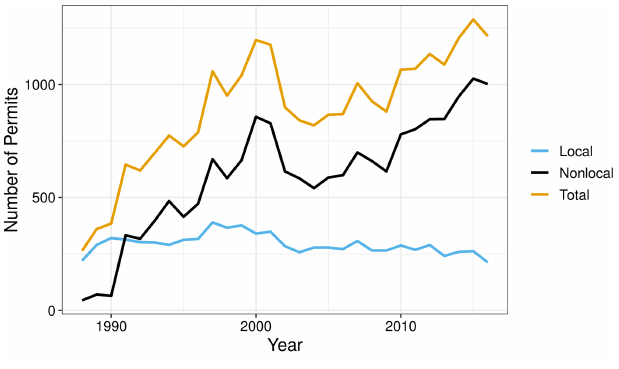
Fig. 5 . Local, nonlocal, and total number of subsistence permits issued for Glennallen subdistrict.